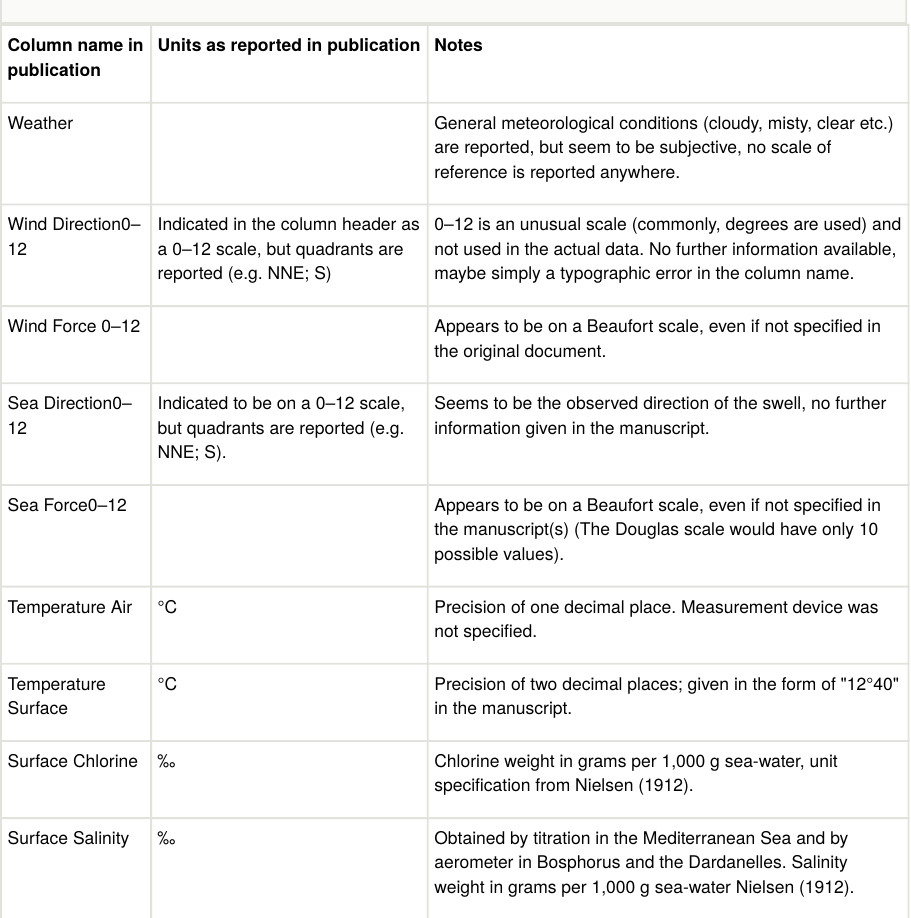
Environmental parameters reported for the samples in the introductory table by Schmidt